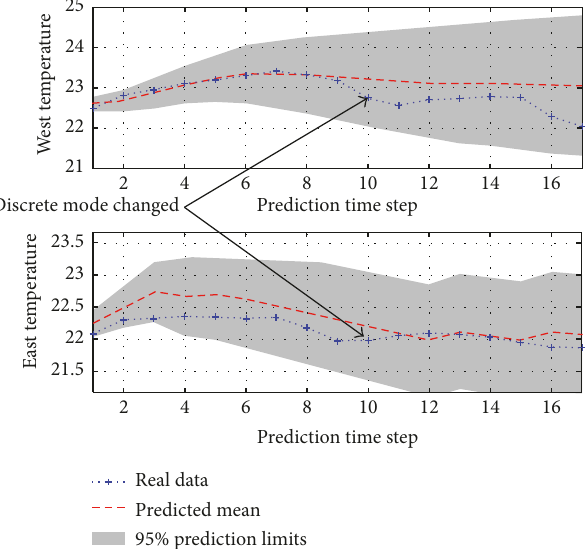
Figure 13: Multistep prediction of zone air temperature for both zones using the proposed SHS